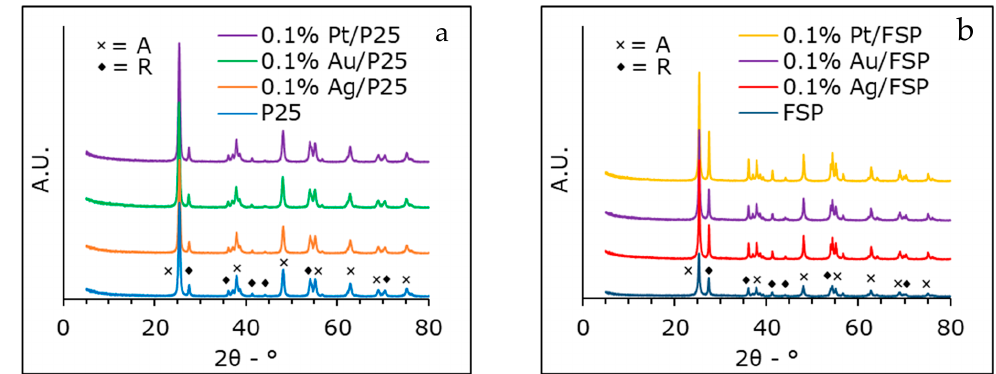
Figure 2. XRD characterisation results for selected catalysts. The peaks labelled with the cross belong to anatase, while the rhombus highlights the peaks of rutile phase. ( a ) Samples supported on P25